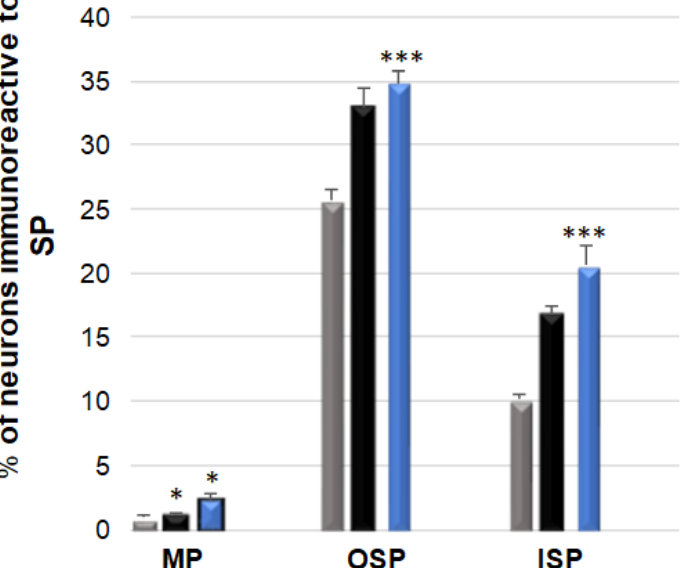
Figure 9. Bar graph showing the percentage variation in the number of substance P (SP)—immuno- reactive neurons as a result of low (black bar) and high (blue bar) dose of acrylamide supplementation in the porcine jejunum enteric plexuses. Control pigs (grey bar), MP—the myenteric plexus; OSP—the outer submucosal plexus; ISP—the inner submucosal plexus. * p < 0.05, *** p < 0.001 point to differences in the expression of exact substance studied with reference to the control pigs.